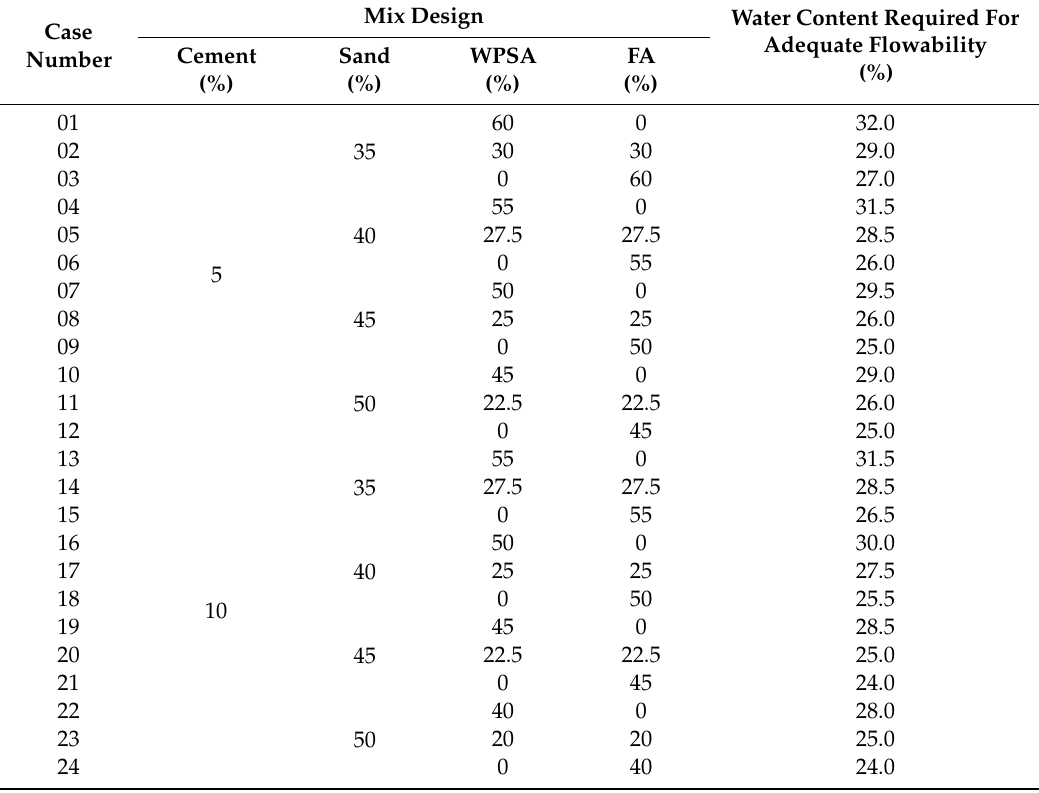
Table 5. Results of flowability tests.